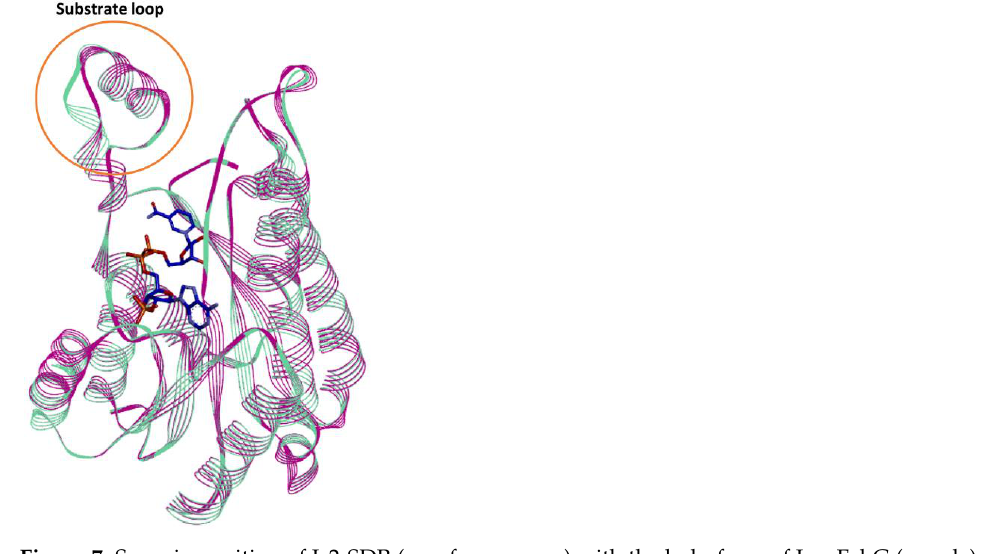
Figure 7. Superimposition of Is2-SDR (apo-form, green) with the holo-form of Lm-FabG (purple).